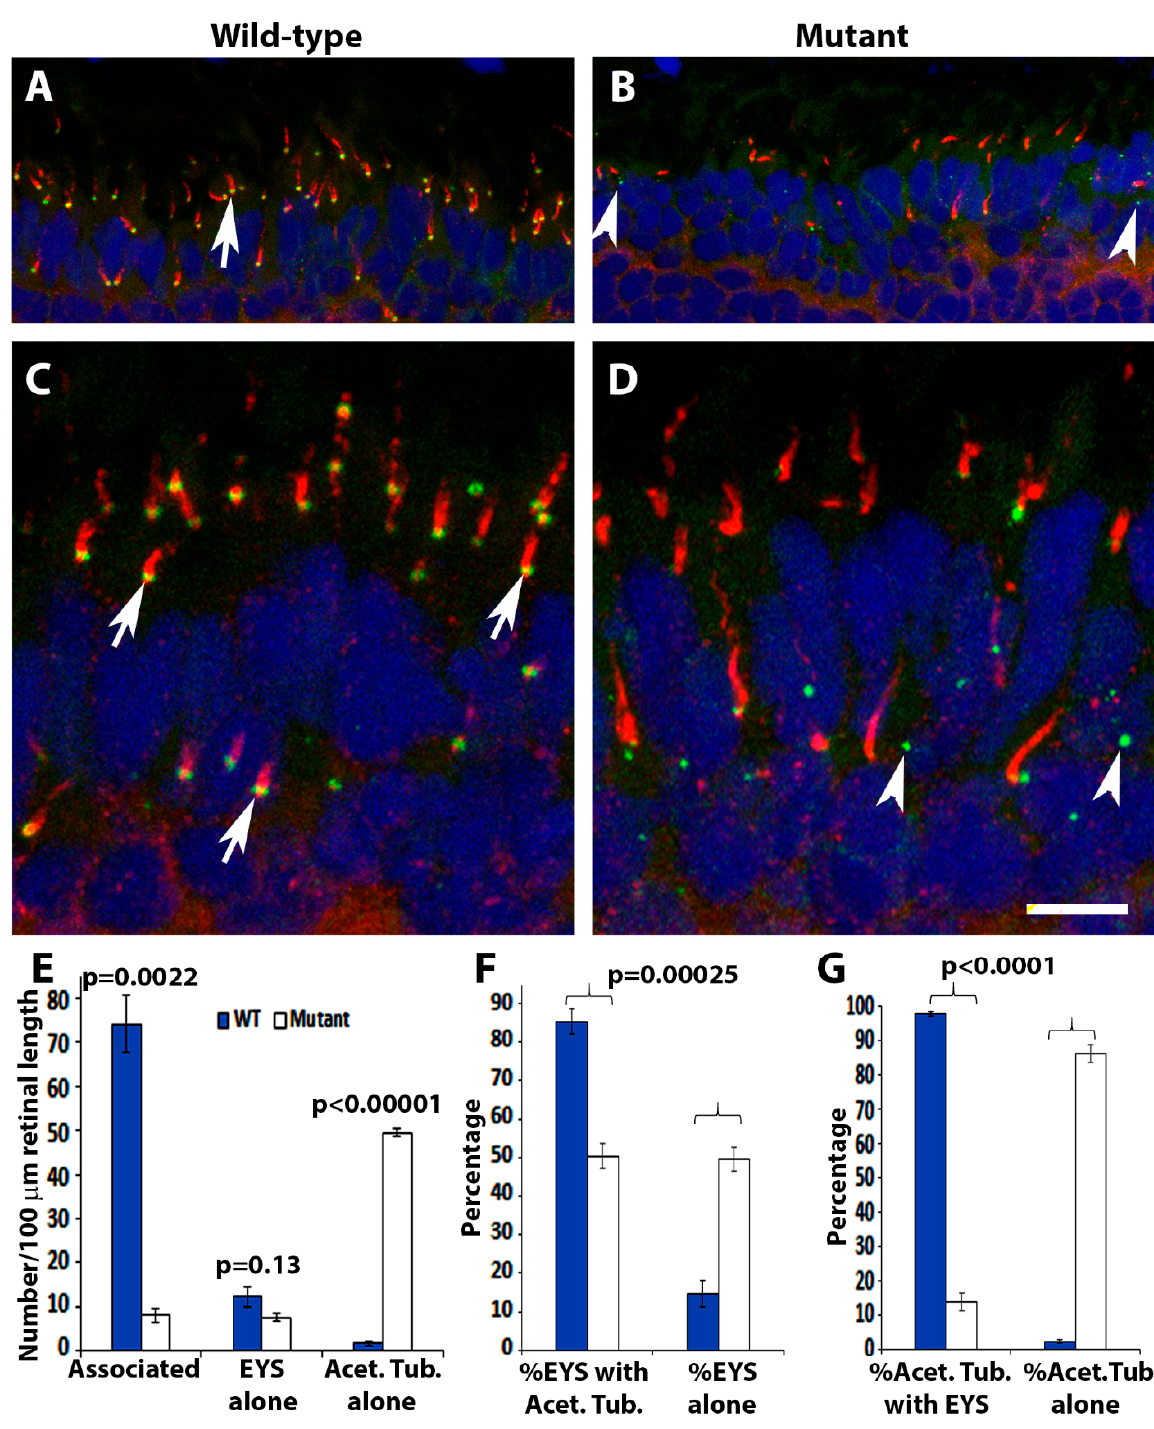
Figure 3. EYS protein was reduced and mis-localized in pomt2 mutant zebrafish retinas. Retinal sections from zebrafish at 1-mpf were double immunostained with EYS (green fluorescence) and acetylated α -tubulin (red fluorescence). The sections were counterstained with DAPI to show nuclei. ( A , C ) Wild-type retina at 1-mpf. Most EYS-positive puncta in the wild-type retina were associated with the basal end of acetylated α -tubulin reactivity (arrows). ( B , D ) pomt2 sny5+13 homozygous mutant retina at 1-mpf. Overall, EYS immunoreactivity in the mutant was much lower than the wild-type. Most of the EYS-positive puncta were not associated with acetylated α -tubulin but were localized to the outer nuclear layer. ( E ) Counting of EYS-acetylated α -tubulin double staining from the outer nuclear layer to the retinal pigment epithelium (RPE) ( n = 3). Note that acetylated α -tubulin